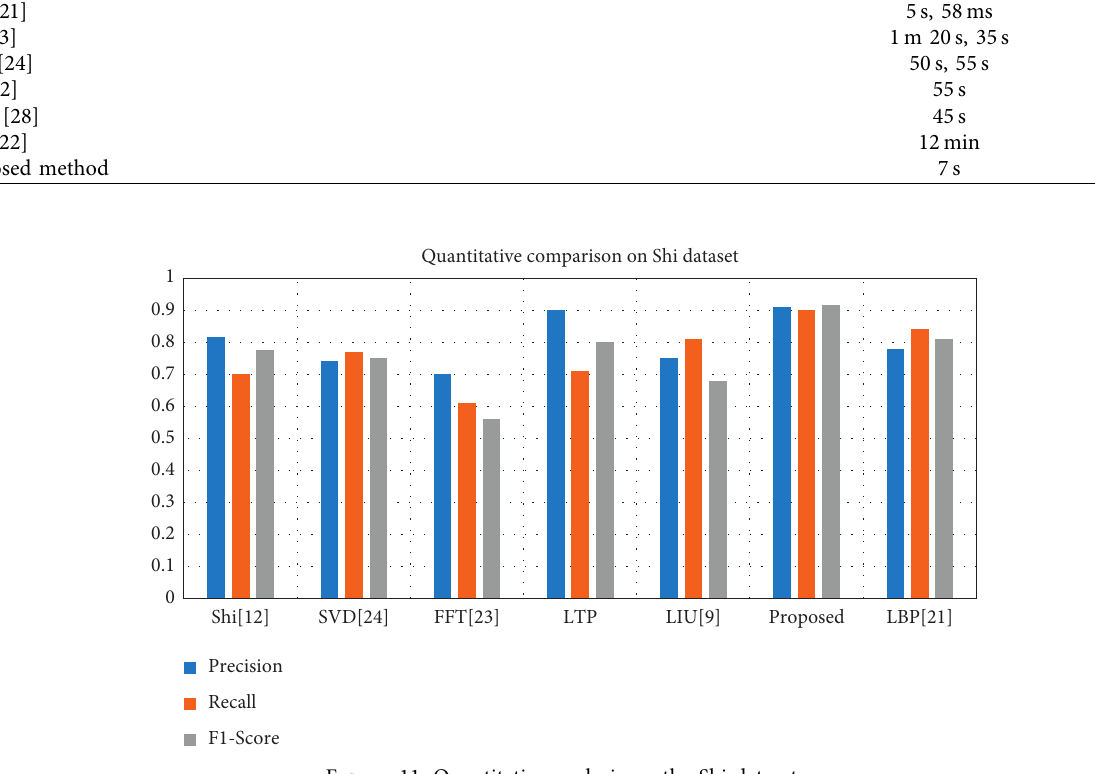
Figure 11: Quantitative analysis on the Shi